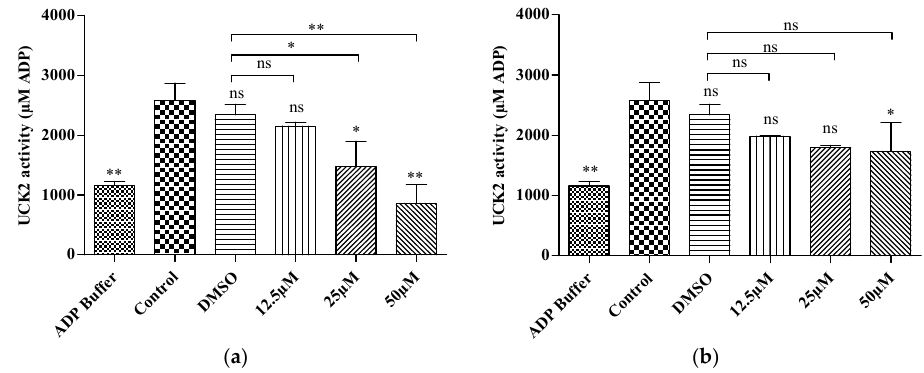
Figure 5. UCK2 enzyme activity was measured based on the amount of ADP produced from the enzyme reaction ( a ) Cell lysate incubated in the presence of FKB ( b ) Cell lysate incubated in the presence of APN. Florescence intensity ( λ ex = 450 nm/ λ em = 590) was monitored using a fluorescence plate reader. Results were expressed as mean ± SD of three independent experiments, * p < 0.05, ** p < 0.01, ns: non-significant when compared to the control.